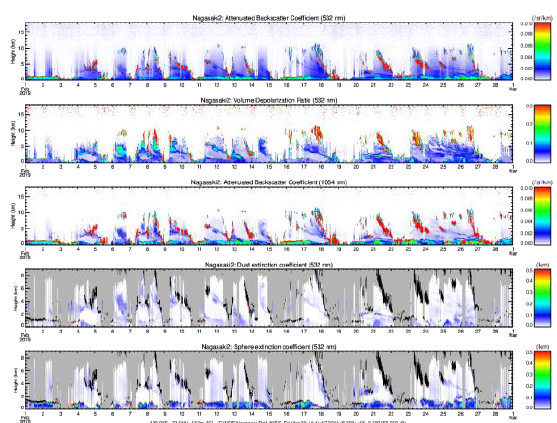
Fig.2 Time-height sections of [from top] attenuated backscatter coefficient (ABC) at 532 nm, volume depolarization ration at 532 nm, ABC at 1064 nm, dust extinction coefficient with cloud mask, spherical particle extinction coefficient with cloud mask for February 2019 in Nagasaki,